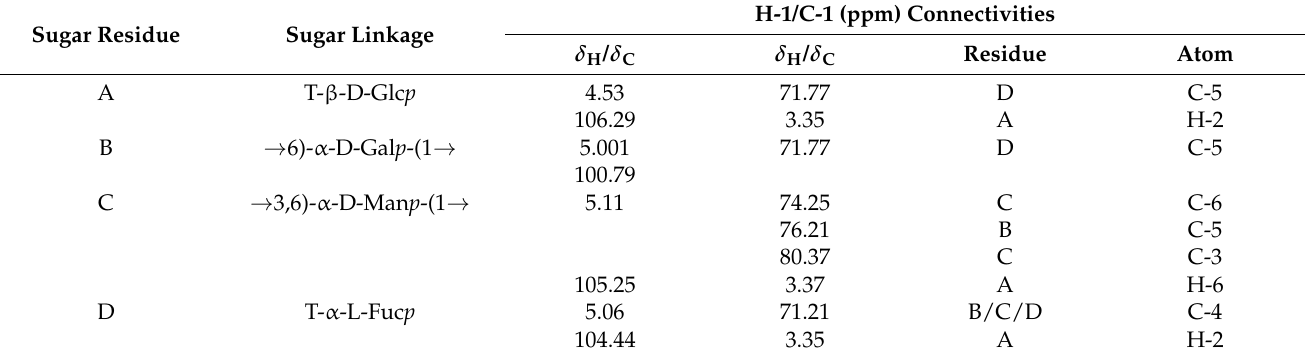
Table 5. Significant connectivity observed in HMBC spectrum for the terminal 1 H and 13 C of the residue fractions of